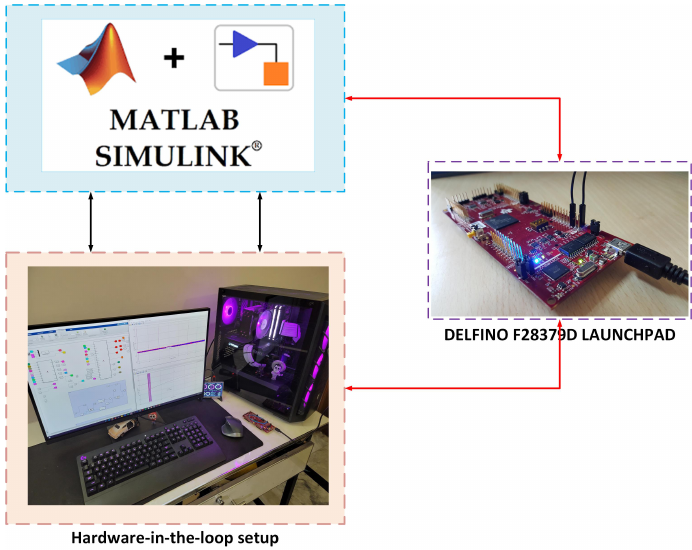
Figure 18. Hardware-in-the-loop test bench.